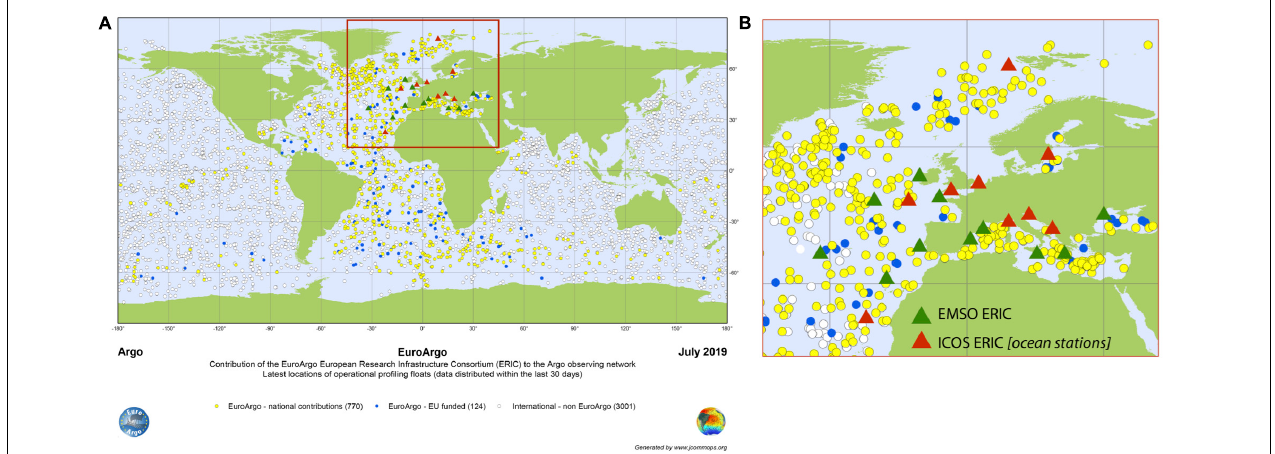
FIGURE 2 | (A) Geographical distribution of the Argo Floats; (B) Zoom square displays: EMSO ERIC distributed Regional Facilities and test sites (green triangles), ICOS ERIC marine stations (red